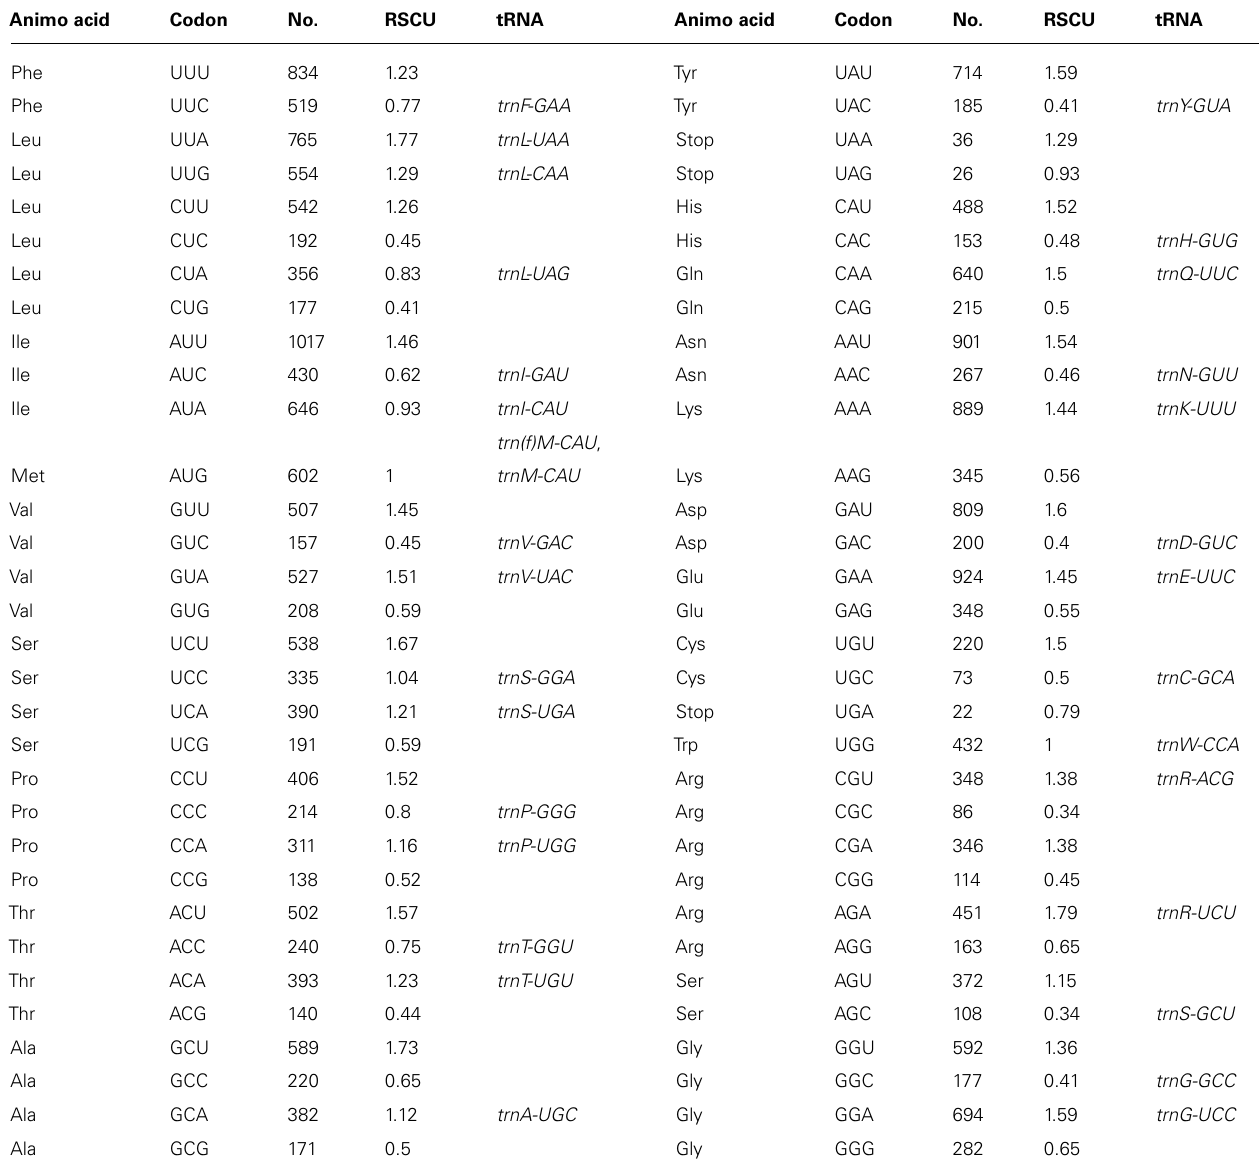
Table 4 |The codon–anticodon recognition pattern and codon usage for the A. barbatum var. puberulum chloroplast genome. Animo